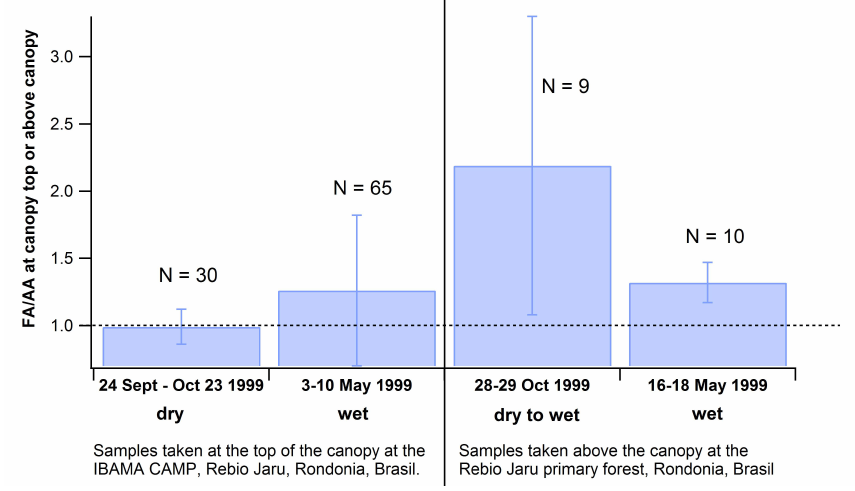
Fig. 6. Daytime (10:00–16:00LT) ratios of FA to AA (nmolmol − 1 FA)/(nmolmol − 1 AA) in the southwestern Amazon during the 1999 dry and wet seasons and the transition from dry to wet. Wet season data at canopy top tended to slightly higher ambient ratios (FA/AA > 1) as compared to the dry season data (FA/AA = 1). The late dry season data at the tower show the opposite with higher values than in the wet season. However, after a drought from June to August, quite substantial rainfall was observed very early in the dry-to-wet season transition in September triggering re-greening of the forest (Kesselmeier et al.,